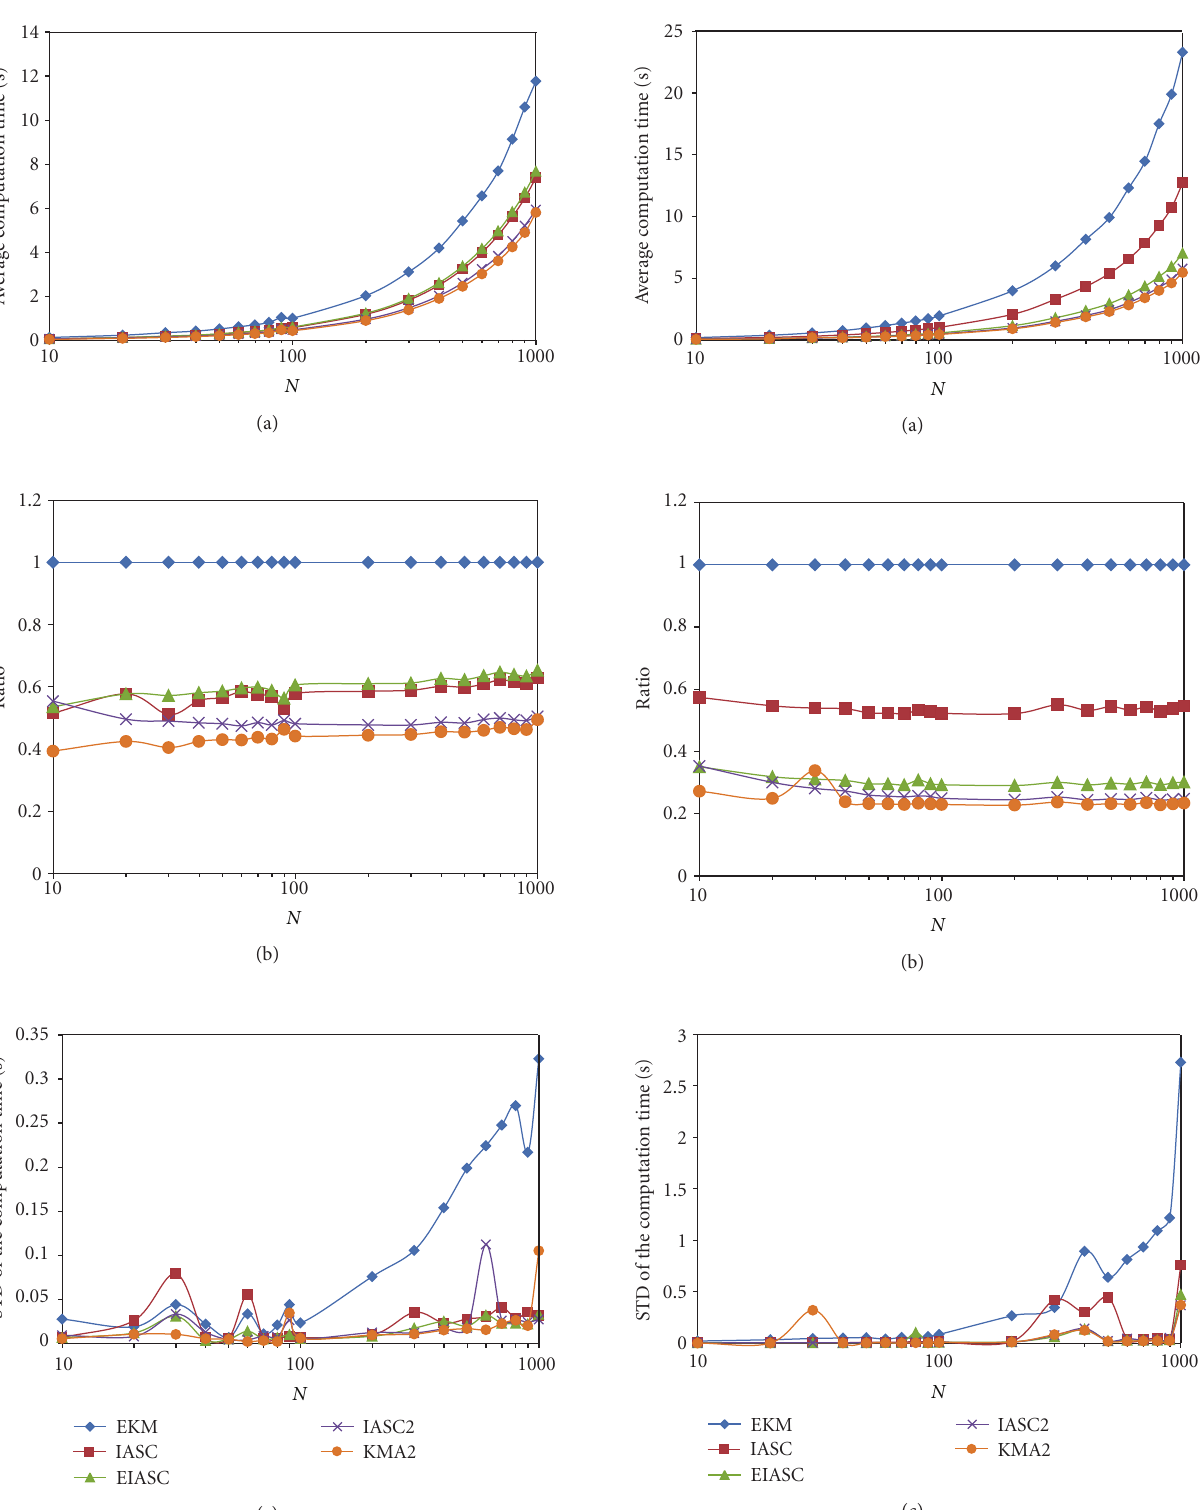
Figure 14: Right-sided random FOU results (interpreted language implementation of the algorithms). (a) Average computation time, (b) ratio with respect to the EKMA, and (c) standard deviation of computation